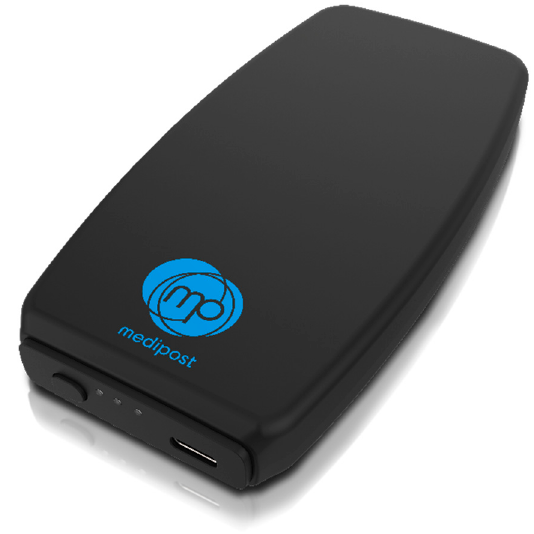
Figure 2. MediPost device, with a USB port for charging the device and battery status indicator on the shorter side of the device.